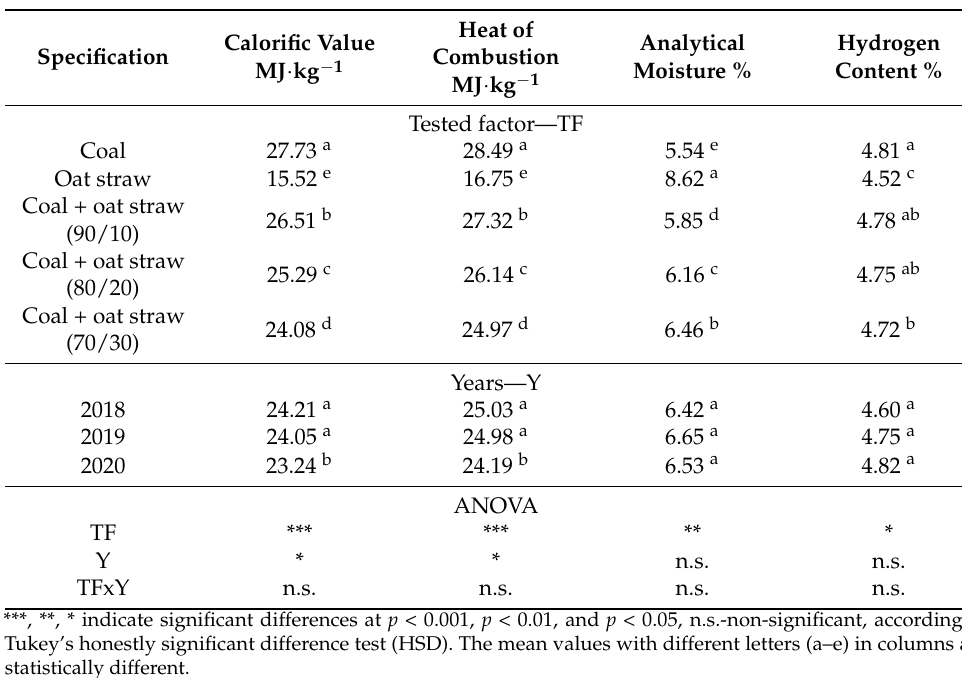
statistically different.